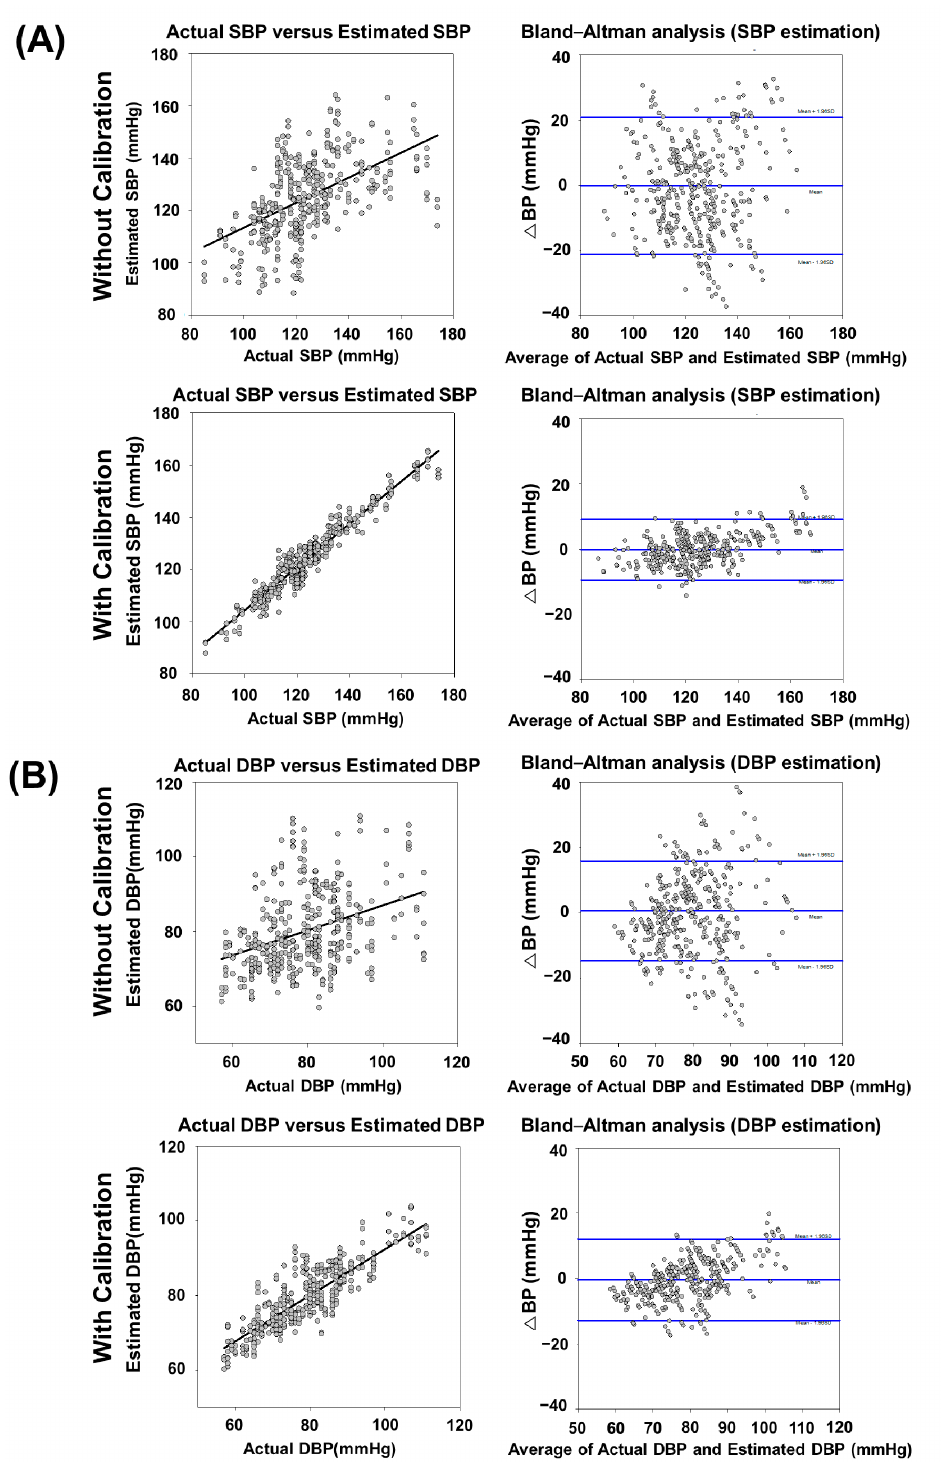
Figure 10. Relationship between actual BP measurement and exponential-GPR estimated BP in the analysis of correlation coefficient and Bland-Altman plot for Δ BP between actual BP measurement and exponential-GPR BP estimation. ( A ) SBP measurement without calibration showed a moderate correlation ( r -value = 0.538 and its associated p = 1.84 × 10 − 30 ) with a mean Δ BP of − 0.1809 mmHg (CI = − 21.1876 to 20.8258) between actual BP measurement and exponential-GPR BP estimation. SBP measurement with calibration showed an excellent correlation ( r -value = 0.968 and its associated p = 1.20 × 10 − 232 ) with a mean Δ BP of − 0.1776 mmHg (CI = − 9.4603 to 9.1051) between actual BP meas- urement and exponential-GPR BP estimation. ( B ) DBP measurement without calibration showed a